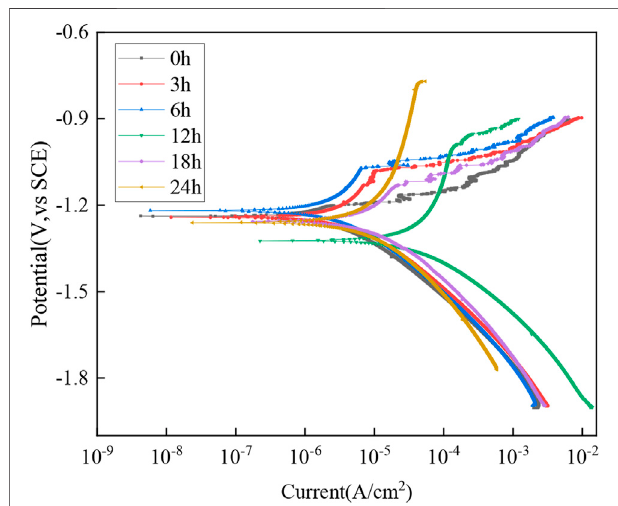
FIGURE 9 | The polarization curves of the specimens with different immersion